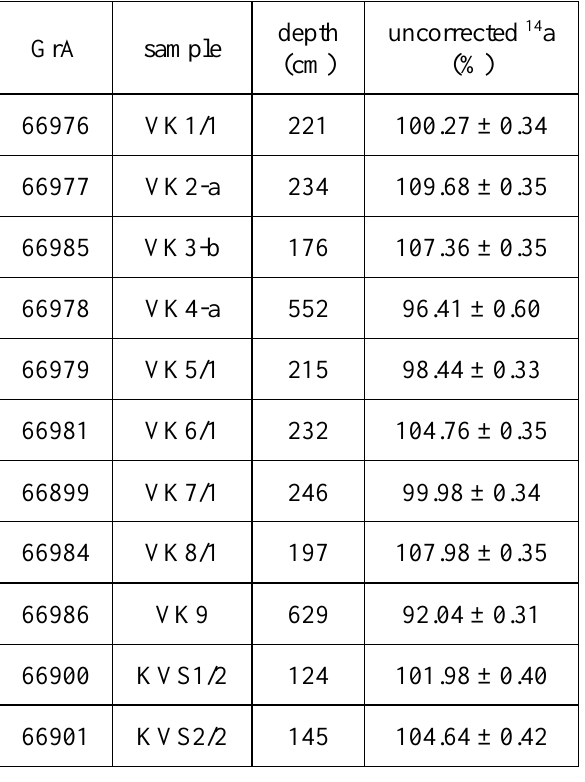
Table 2. Radiocarbon activities for groundwater samples in